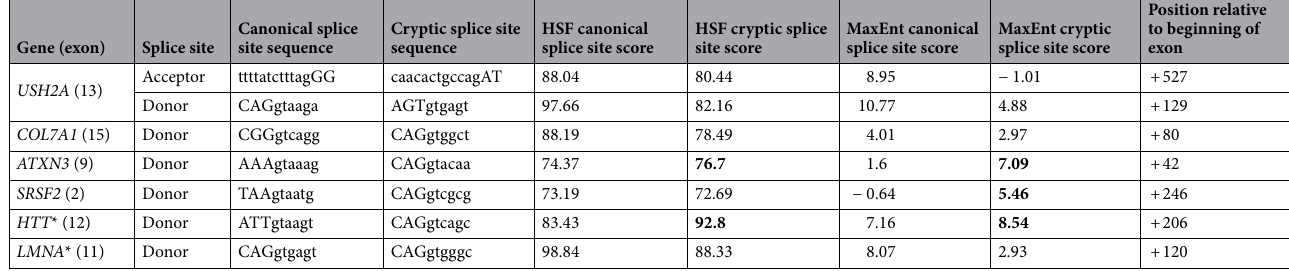
Table 1. Comparing canonical and cryptic splice site scores using two different modeling approaches. Cryptic splice site scores that are higher than the canonical splice site scores are highlighted in